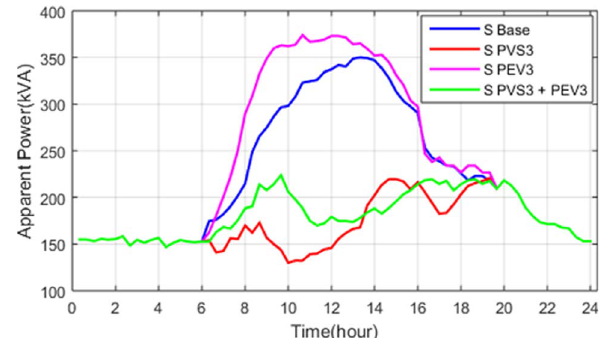
Figure 5. Analysis of statistical parameters of active energy pro fi les of lumped loads for summertime.